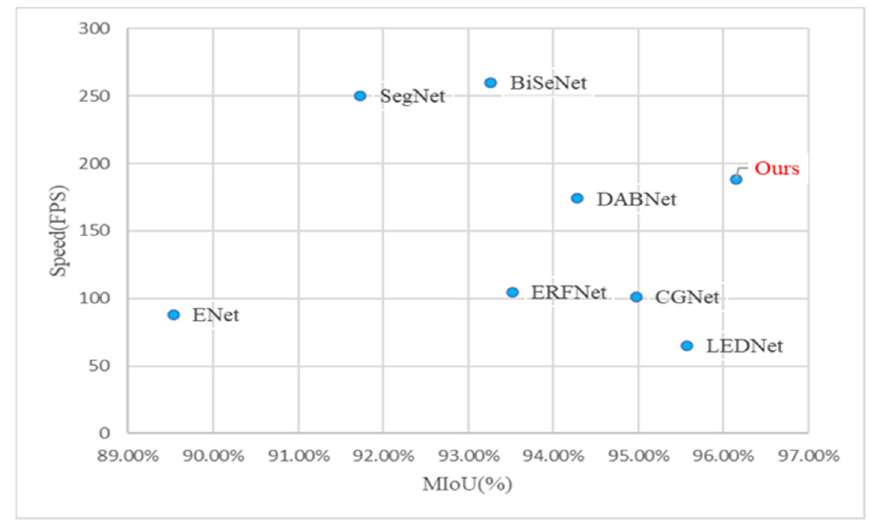
Figure 7. Comparison of the accuracy and speed of the different methods.